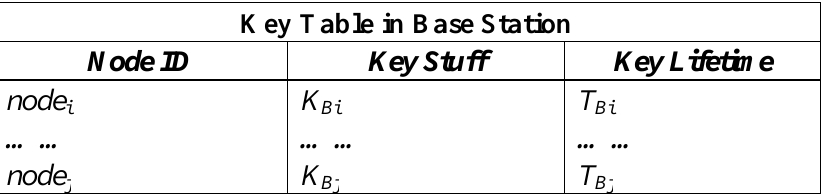
Table 3. The structure of Key Table in basestation. Key Table in Base